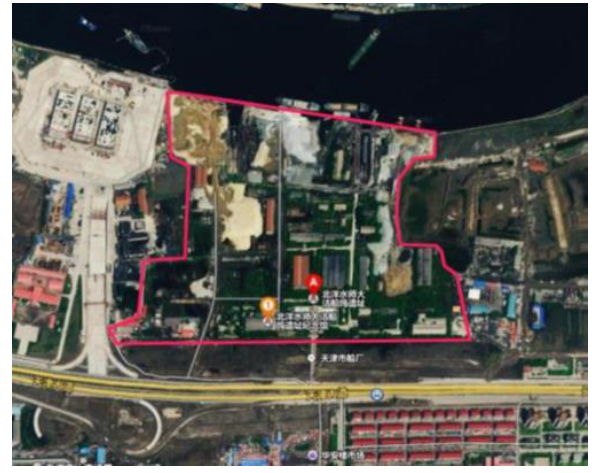
Figure 2. Location and proposed protection boundary (within the pink boundary) of the Dagu Dock of Beiyang